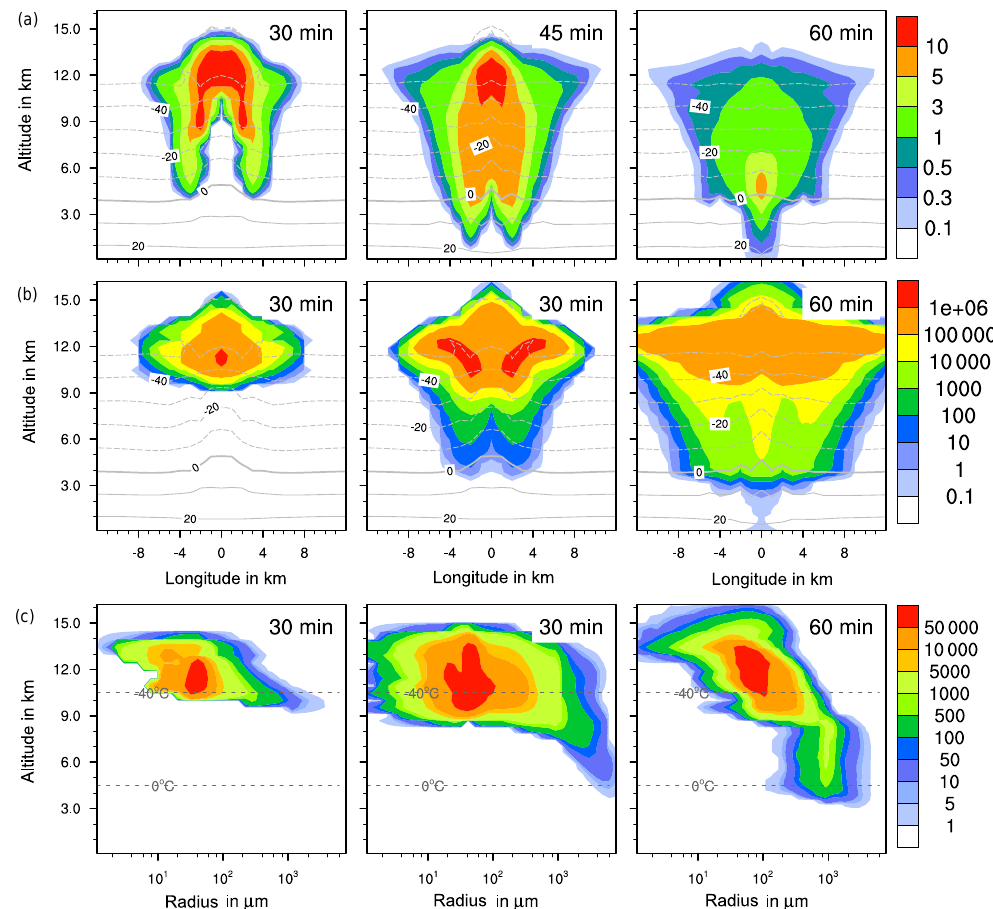
Figure 4. Ice formation from the reference case with homogeneous freezing. (a, b) Temporal development of two parameters shown in a vertical cut through the cloud center. Horizontal dashed lines: temperature in ◦ C. (a) Ice water contents in gkg − 1 and (b) ice particle numbers per m 3 . (c) Ice particle size spectra in the center cell of the cloud at different times. Number concentrations per m 3 . Left pictures in (b) and (c) show primary homogeneous freezing